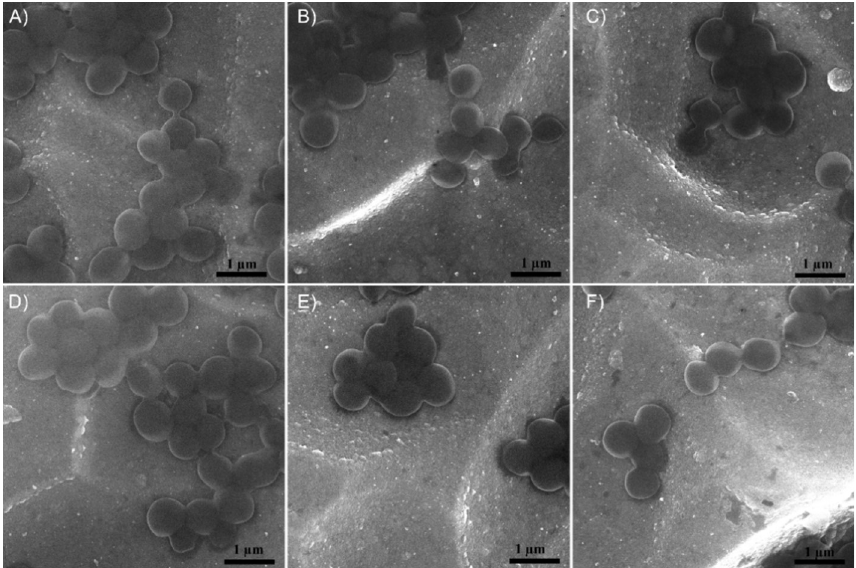
Figure 11. SEM images of Staphylococcus aureus ATCC 25923 cell development on HAp coated the Si discs used as the control ( A , D ), and the ZnHAp-500 and ZnHAp-700 layers after 24 h ( B , C ) and 48 h ( E , F ) of incubation.